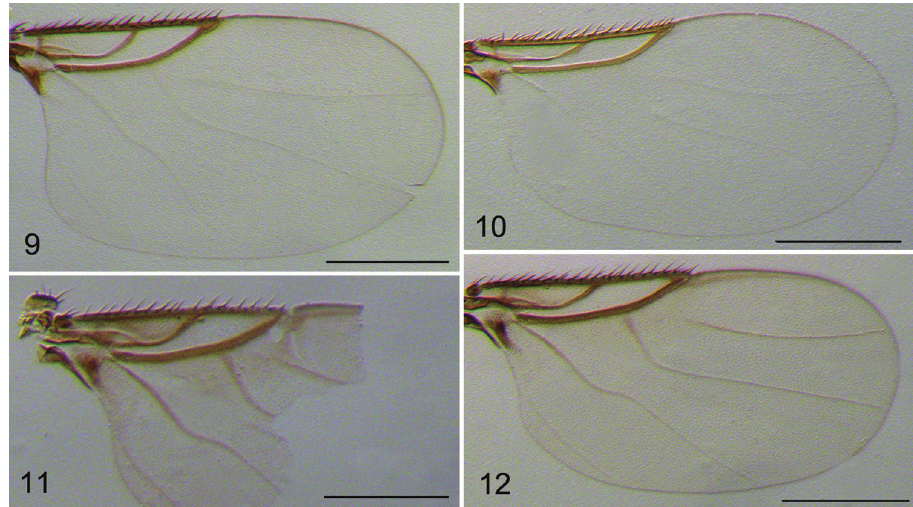
Figures 9–12. Wings. 9–10 D. chaetocauda . 9 male 10 female 11 D. sigmoides, male 12 D. zaitzevi, male. Scale bars 0.2